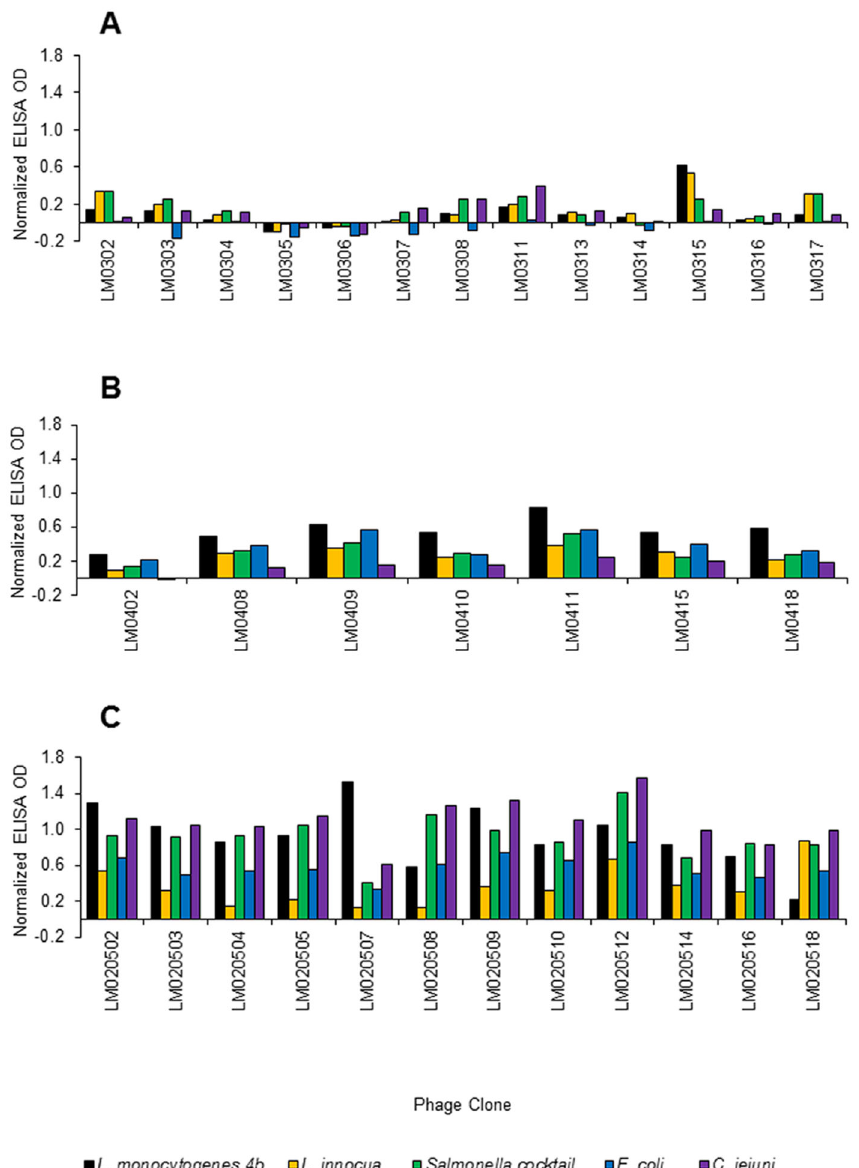
Figure 2. Phage binding ELISA specificity study for phage clones obtained at different stages of biopanning. (A) after surface biopanning round 3 (B) after surface biopanning round 4A and (C) after solution biopanning round 5. Each experiment performed once only due to limited amount of phage clone stock available for testing. Normalized data equates to relative OD signal after subtraction of background OD